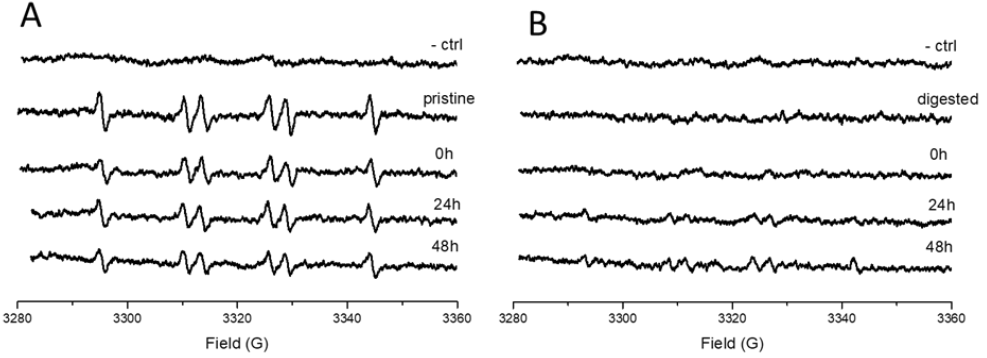
Figure 9. Effect of digestion and cell media incubation on the surface reactivity of TiO 2 -NM1. EPR